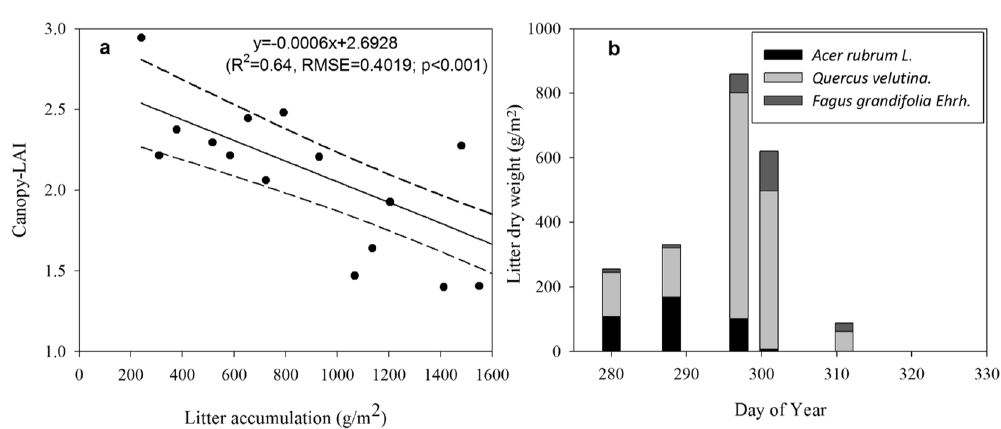
Figure 3. The process of autumn abscission. ( a ) The correlation between litter accumulation and canopy- LAI during leaf abscission (R 2 = 0.64; p < 0.001), and the dotted lines represent 95% confidence interval; ( b ) Collected litter dry weights on October 7 th , 15 th , 24 th , 28 th and November 7 th ,